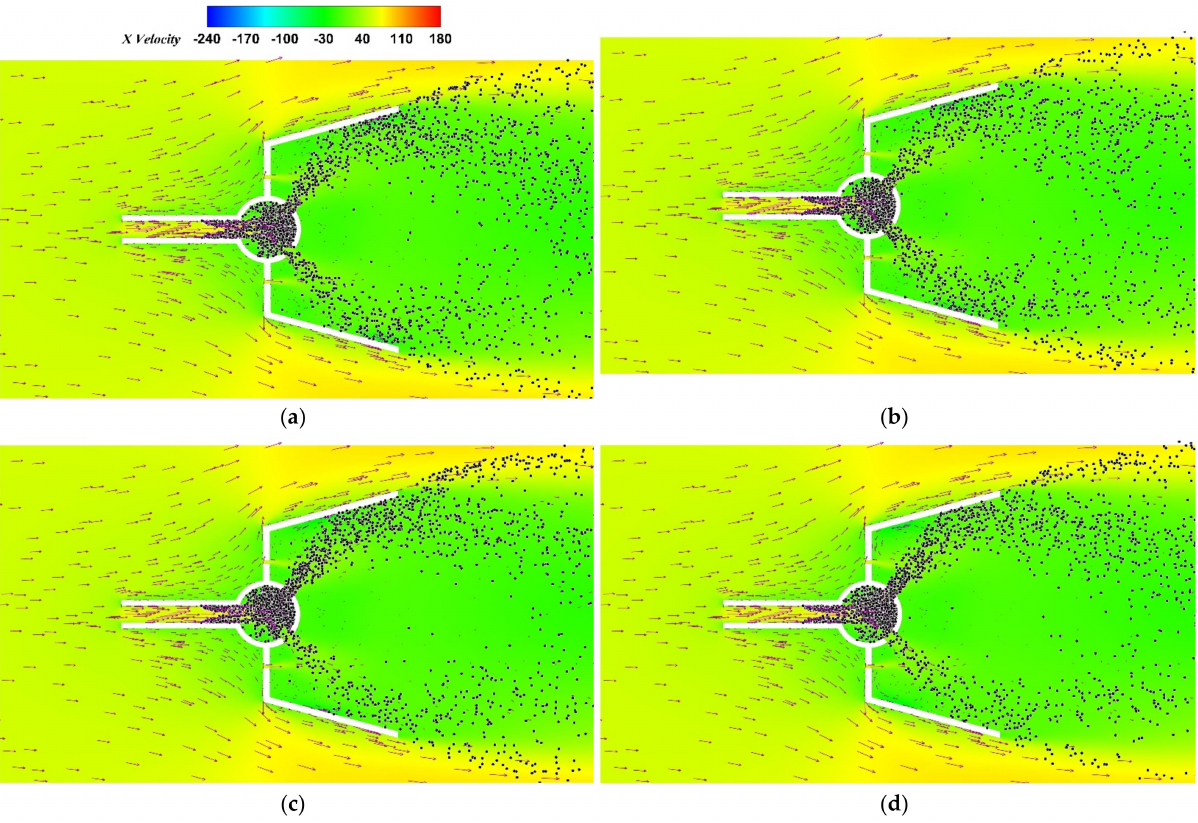
Figure 18. Spray field under different actuation positions with 5 mm actuation length on inner surface: ( a ) P1 position, ( b ) P2 position, ( c ) P3 position, ( d ) P4